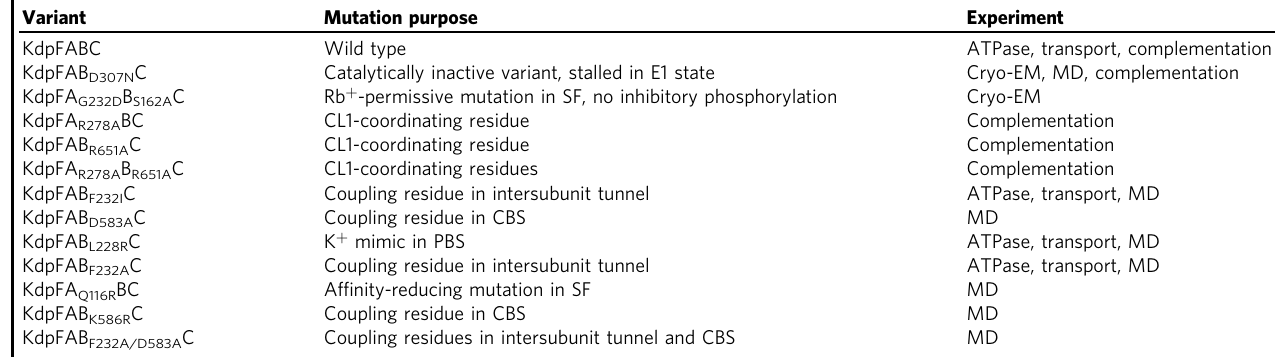
Table 1 KdpFABC variants used in this